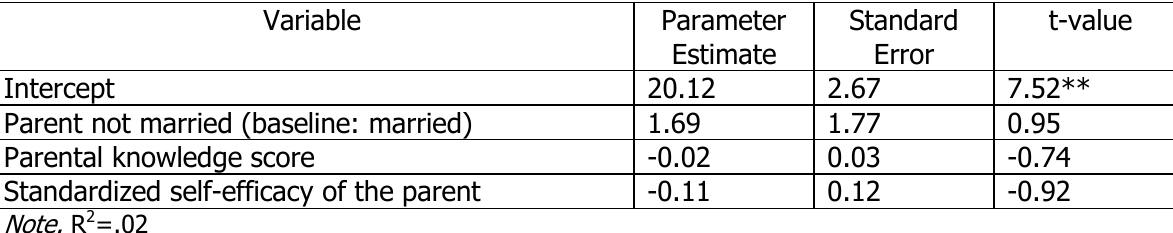
Summary of Regression Analysis on Discrepancy in